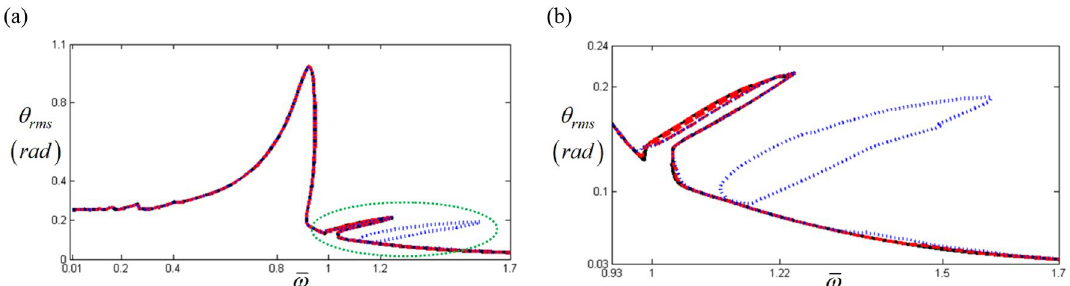
Figure 5. Comparison of HBM results under various excitation conditions: ( a ) the HBM results under frequency up-sweeping; ( b ) comparison of sub-harmonic responses under various excitations. Key: Black line, HBM result with ε = 1 × 10 − 5 ; Red dashed line HBM result with ε = 1 × 10 − 3 ; Blue dotted line, HBM result with ε = 2.9 × 10 − 3